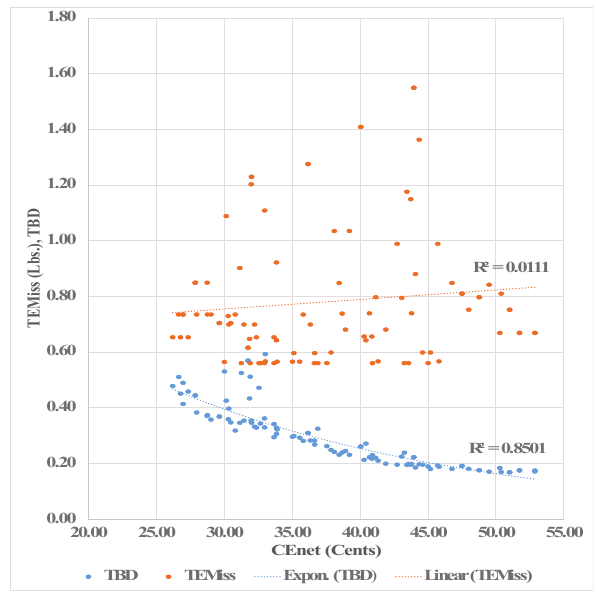
Figure 2. Un-even trends for TEMiss as related to CEnet and TBD